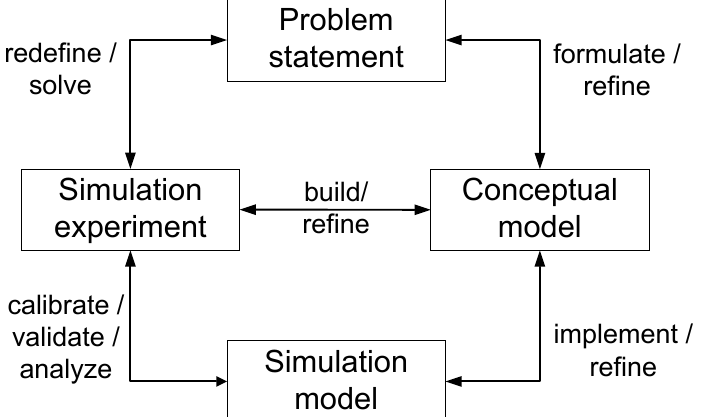
Figure 1. Simplified life cycle of a modeling and simulation study with its main artifacts and